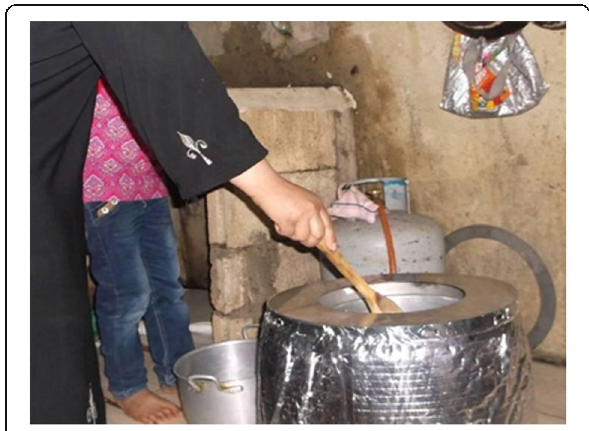
Fig. 3 Utilization of the SET4food pot skirt in a household in